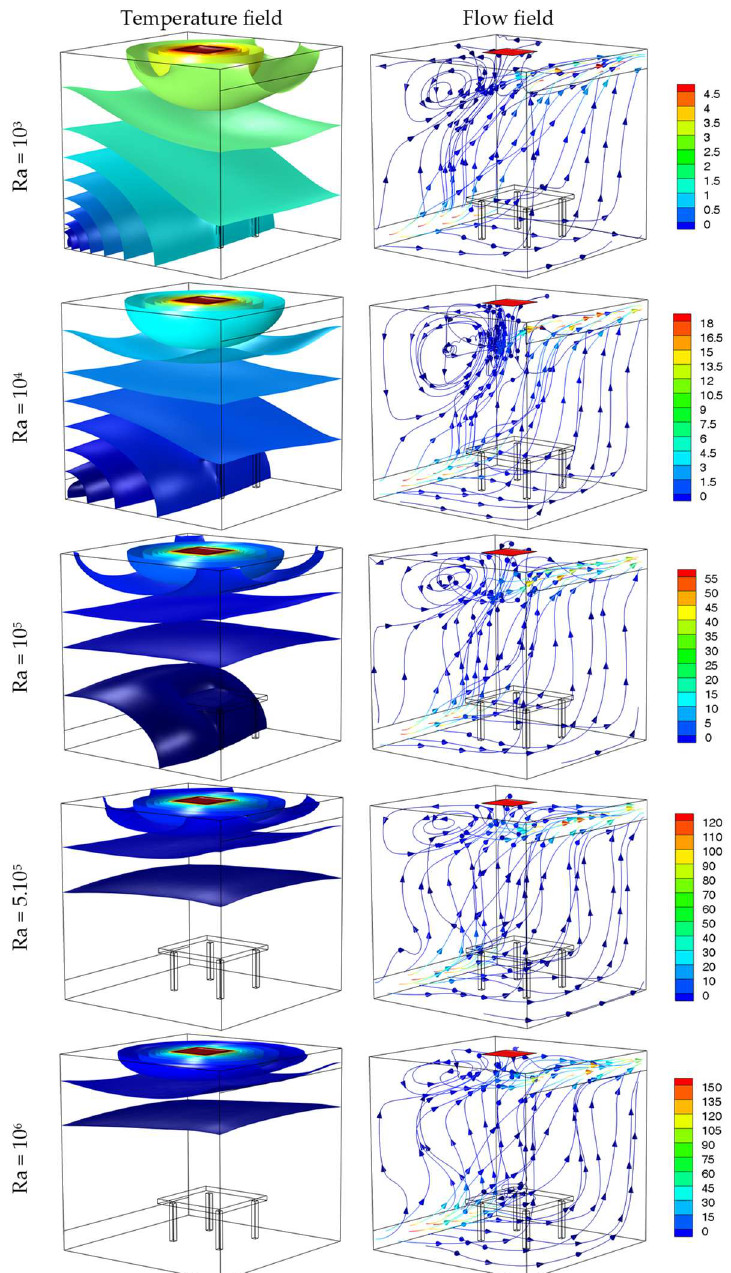
Figure 10. Effect of Rayleigh number variation on the distribution of temperature iso-surfaces and particle trajectories for a heat source position as indicated in case 6.